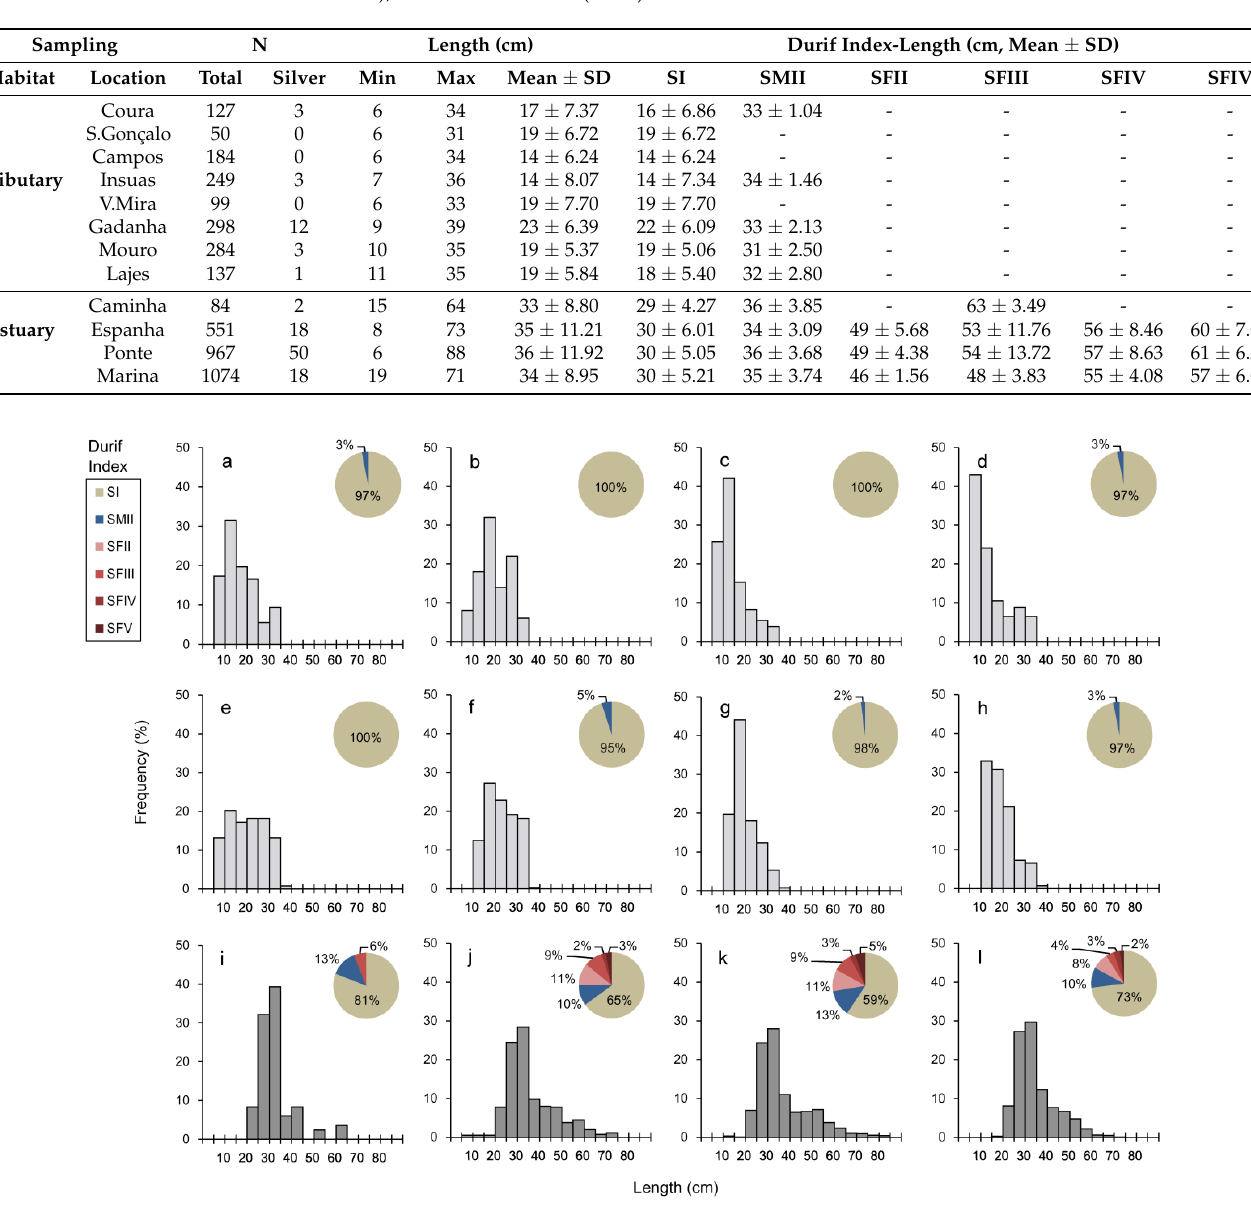
Figure 3. Catch length composition of the eels collected in the tributaries (( a ) Coura, ( b ) S.Gonçalo, ( c ) Campos, ( d ) Insuas, ( e ) V.Mira, ( f ) Gadanha, ( g ) Mouro, and ( h ) Lajes) and in the estuaries (( i ) Caminha, ( j ) Espanha, ( k ) Ponte, and ( l ) Marina). Pie charts present the proportion of individuals sampled according to the life stage classification based on the Durif Silvering Index (Durif et al. 2009): yellow resident (SI and SFII), female pre-migrant (SFIII), silver female (SFIV and SFV), and silver male (SMII).